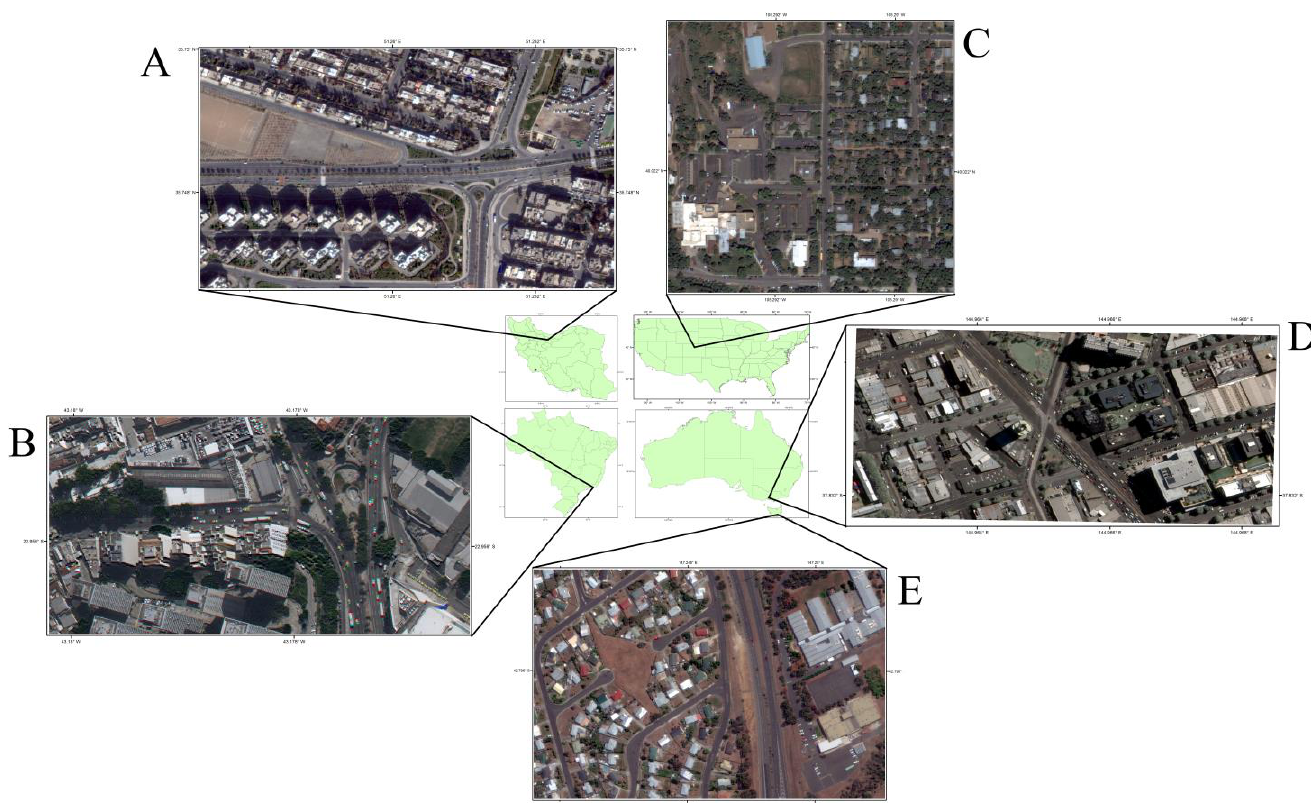
Figure 2. The study areas included Tehran ( A ), Rio de Janeiro ( B ), Denver ( C ), Melbourne ( D ), and Hobart ( E ).